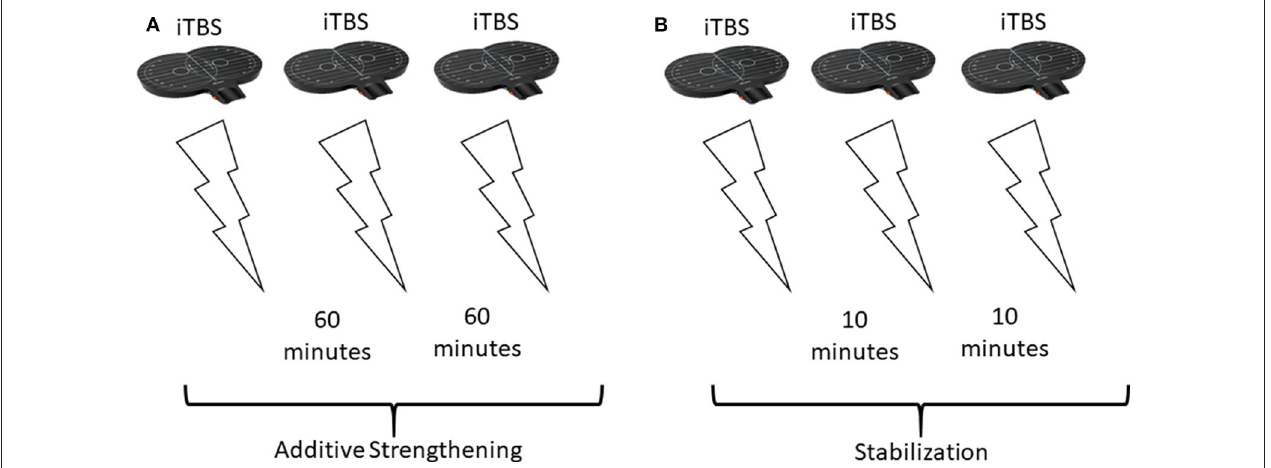
FIGURE 1 | Theoretical stimulation setup and effects in response to different spacings between repeated stimulations. (A) Repeating excitatory (iTBS) stimulation 3 times, with 60min between sessions, promotes additive strengthening of stimulated synapses. Overall, the repeated stimulation increases potentiation [this has been shown in animals using a different TBS protocol (43, 45)]. (B) Repeating the same 3 iTBS stimulations, but with only 10min between sessions results in stabilization (homeostatic metaplasticity) and no change in overall plasticity.